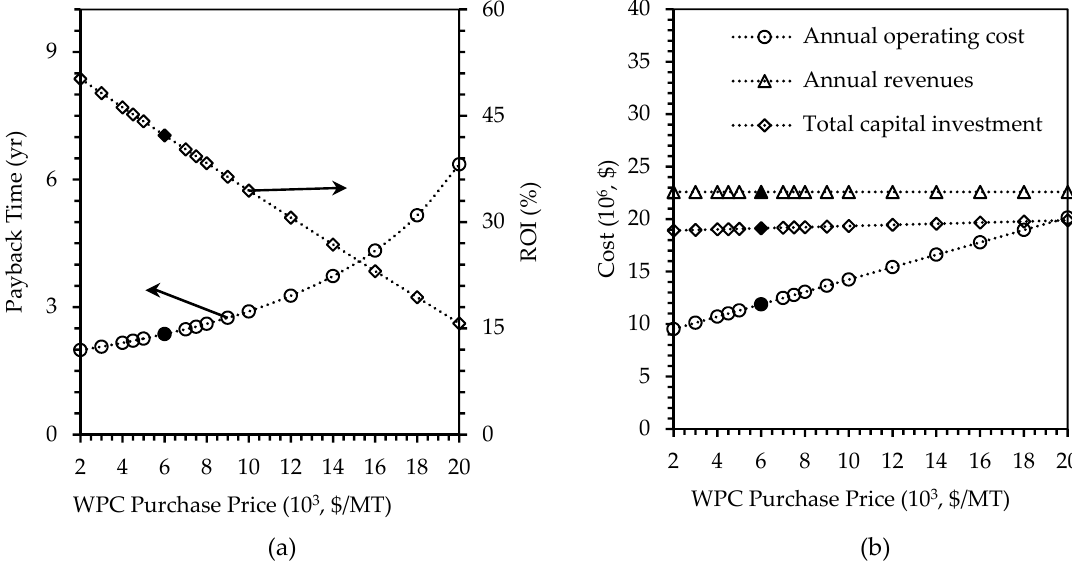
Figure 10. Effects of changing WPC purchase price, on ( a ) payback time in years and ROI in percent, and ( b ) annual operating cost, annual revenues, and total capital investment in U.S. dollars. Filled markers represent results of the base case scenario.